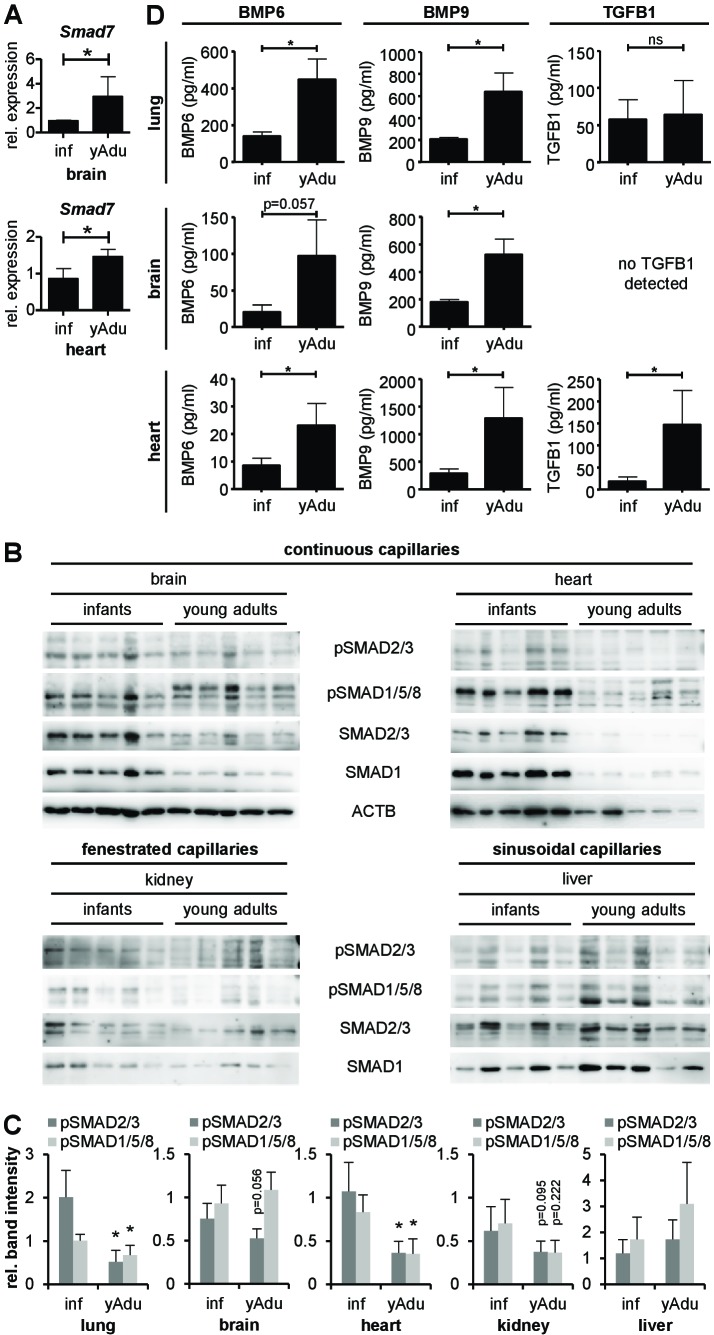
TGFß family signaling in different organs of infant and young adult mice.(A) Validation of Smad7 induction during vessel maturation in brain and heart by qPCR. n = 4; mean ±SD; *p<0.05; Mann-Whitney Test. (B) Immunoblot showing the analysis of TGFβ family signaling in whole brain, heart, kidney and liver lysates of infant (n = 5) and young adult (n = 5) mice. (C) Quantification of immunoblots showing pSMAD2/3 and pSMAD1/5/8 level in different tissues. n = 5; mean ±SD; *p<0.05; Mann-Whitney Test. (D) BMP6, BMP9 and TGFB1 level measured by ELISA in lung, brain and heart. n = 4; mean ±SD; *p<0.05; Mann-Whitney Test.